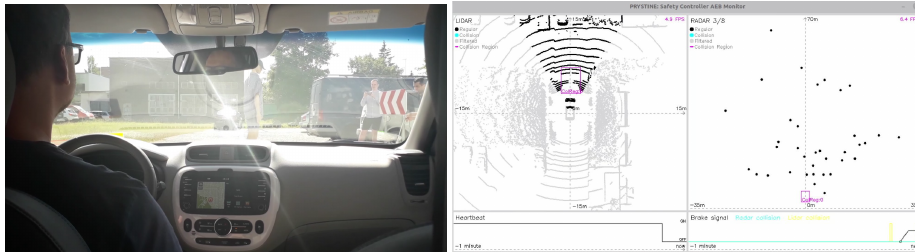
Figure 7. Snapshot of testing use-case with a pedestrian crossing the road without paying attention. Image on the right shows GUI (colours inverted) for the Aurix-based processing of LIDAR and RADAR data, heartbeat monitoring and break